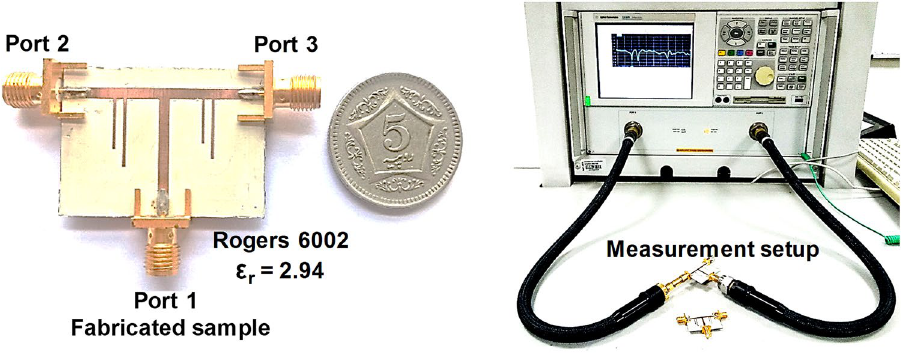
Figure 4. (Left) Fabricated sample of the proposed microstrip diplexer. (Right) Measurement setup showing the VNA connected to the fabricated device.